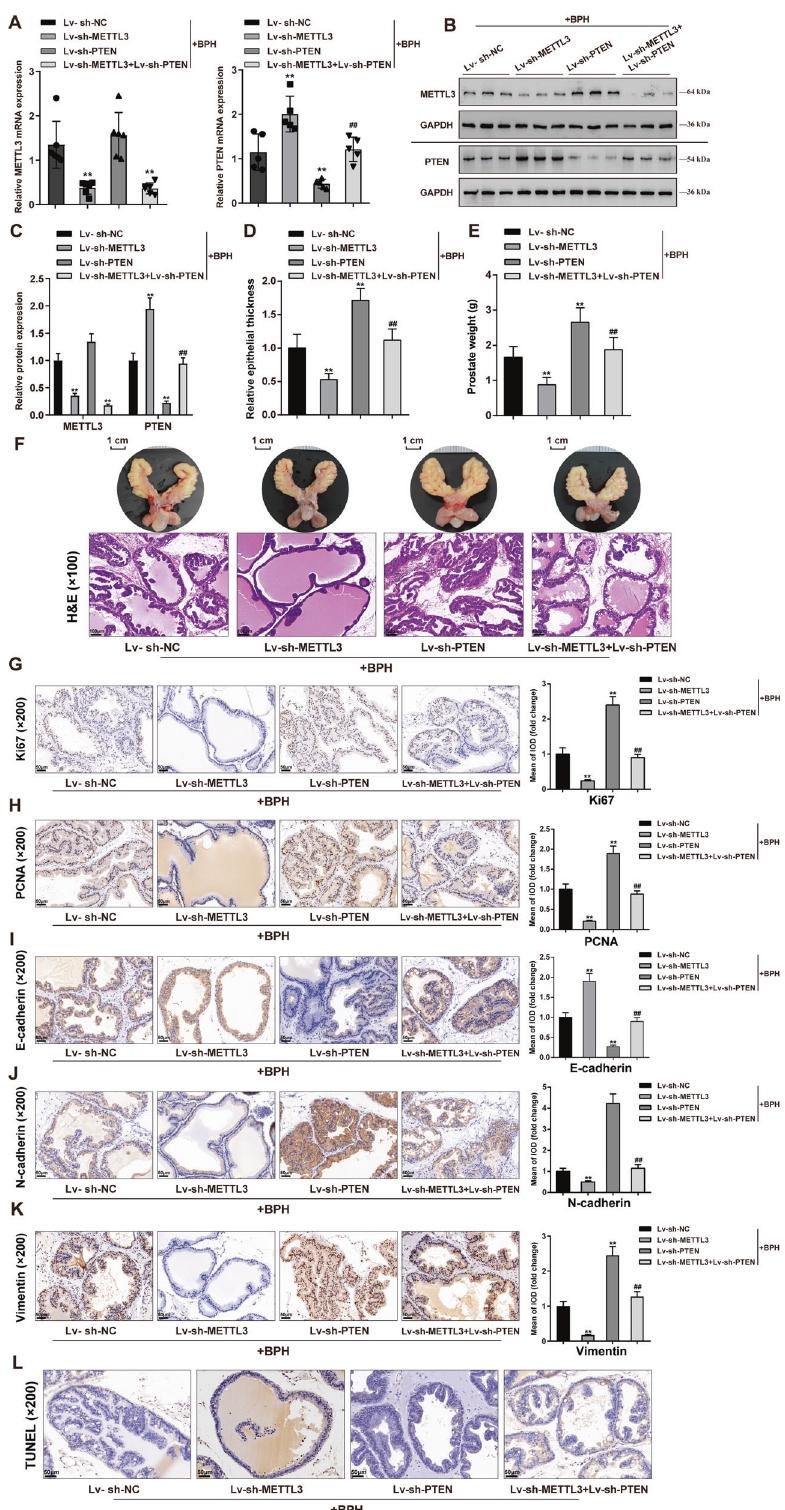
Fig. 6 METTL3 regulates PTEN and affects cell proliferation and EMT in prostatic hyperplasia model rats. BPH model was established in rats as described above; rats were injected with Lv-sh-METTL3 and/or Lv-sh-PTEN and examined for A – C the mRNA and protein expressions of METTL3 and PTEN in rats ’ prostate using qRT-PCR and Immunoblotting; D – E prostatic epithelial thickness and prostate weight at the end of the modeling and treatment; F a representative prostate with the urinary bladder from each group (upper) and the histopathological characteristics of rats ’ prostate from each group using H&E staining (down); Scale bar = 1 cm or 100 μ m; G – K the contents of Ki67, PCNA, E-cadherin, N-cadherin, and vimentin in rats ’ prostate tissues using Immunohistochemical (IHC) staining; L cell apoptosis in rats ’ prostate using TUNEL assay; scale bar = 50 μ m. ** P < 0.01, compared with the Lv-sh-NC group. ## P < 0.01, compared with the Lv-sh-METTL3 group.